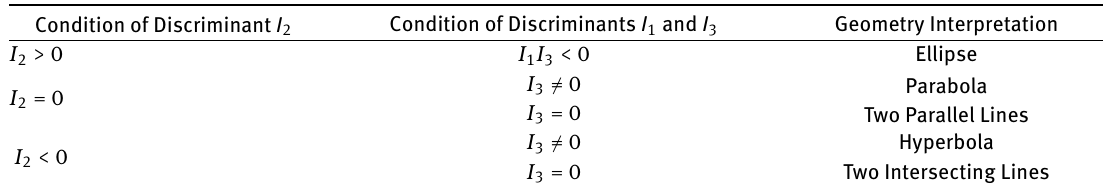
Table 1: Using discriminants I 1 , I 2 and I 3 to determine the locus of a general quadratic equation containing two variables x and y